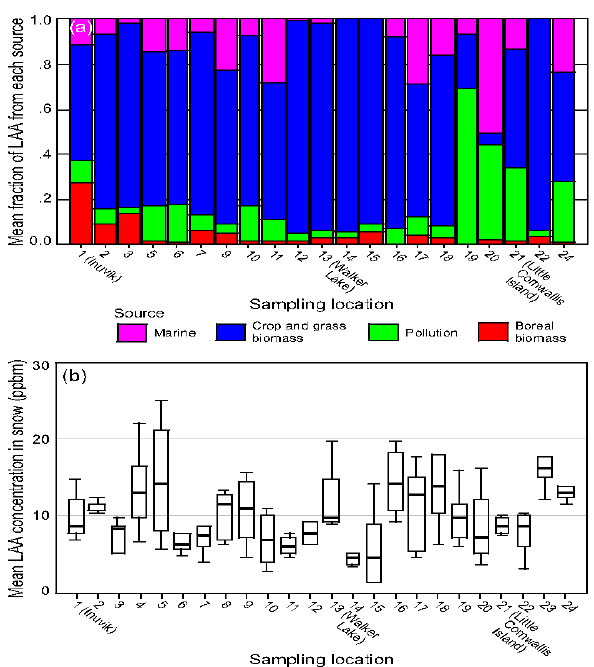
Fig. 7. (a) Average fractional source contributions to the LAA con-